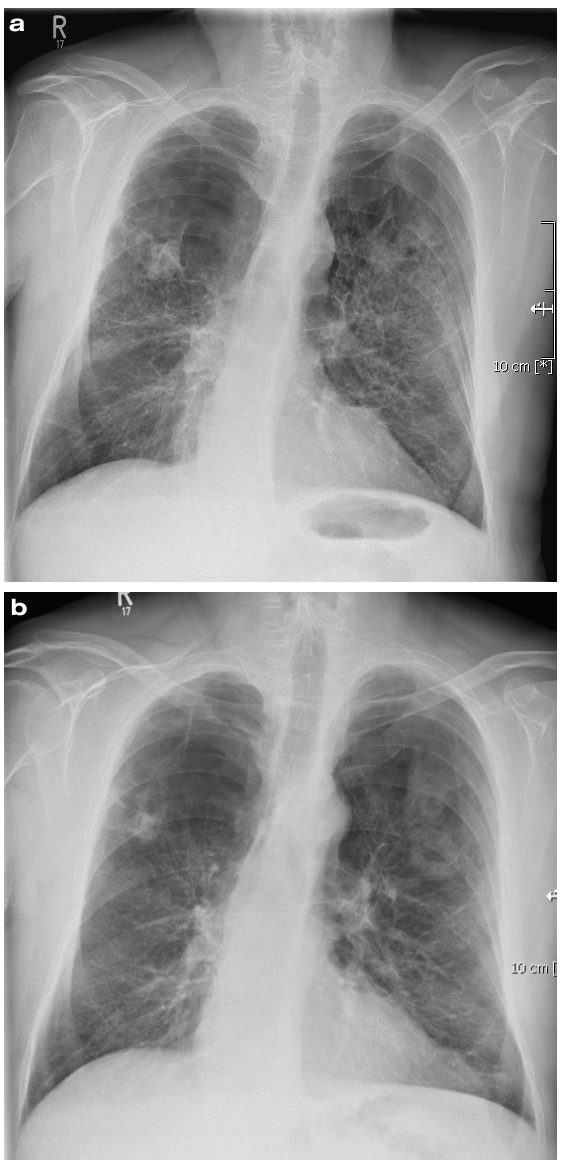
Figure 1. a Chest x- rays before the endoscopic lung volume reduction. b Shows atelectasis of both right and left upper lobe after endoscopic lung volume reduction.